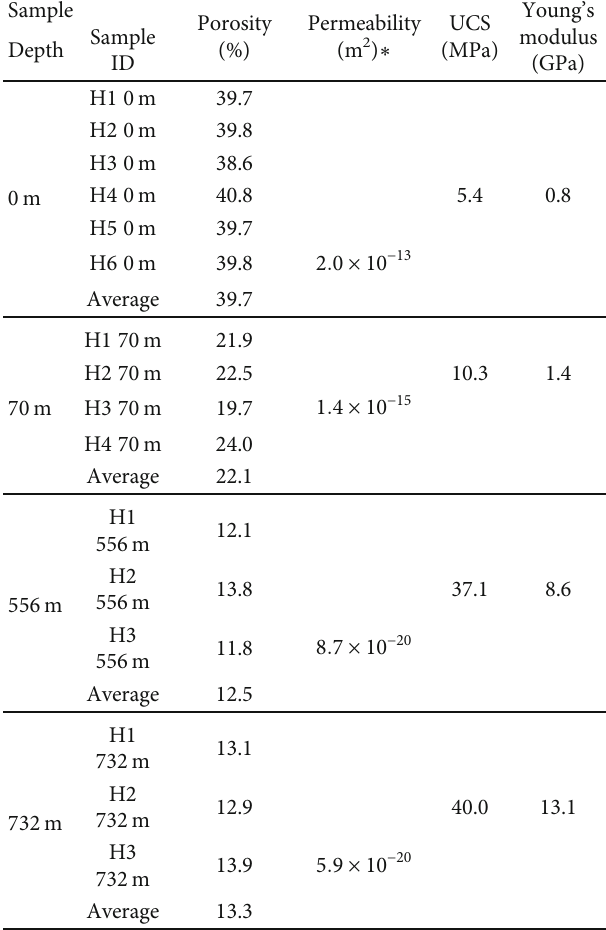
Table 3: Porosity, permeability, uniaxial compressive strength, and Young ’ s modulus results.